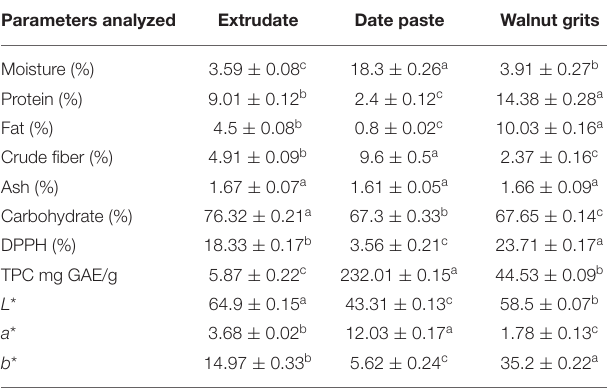
TABLE 2 | Proximate and color analysis of extrudates, date paste, and walnut grits. Parameters